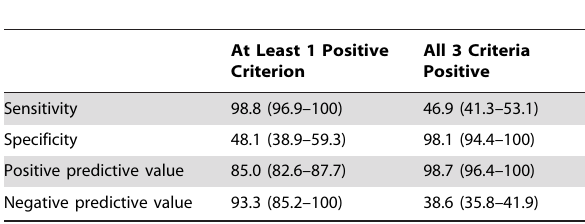
Table 5. Internal Validation to Predict Severe ADAMTS13 Deficiency at Clinical